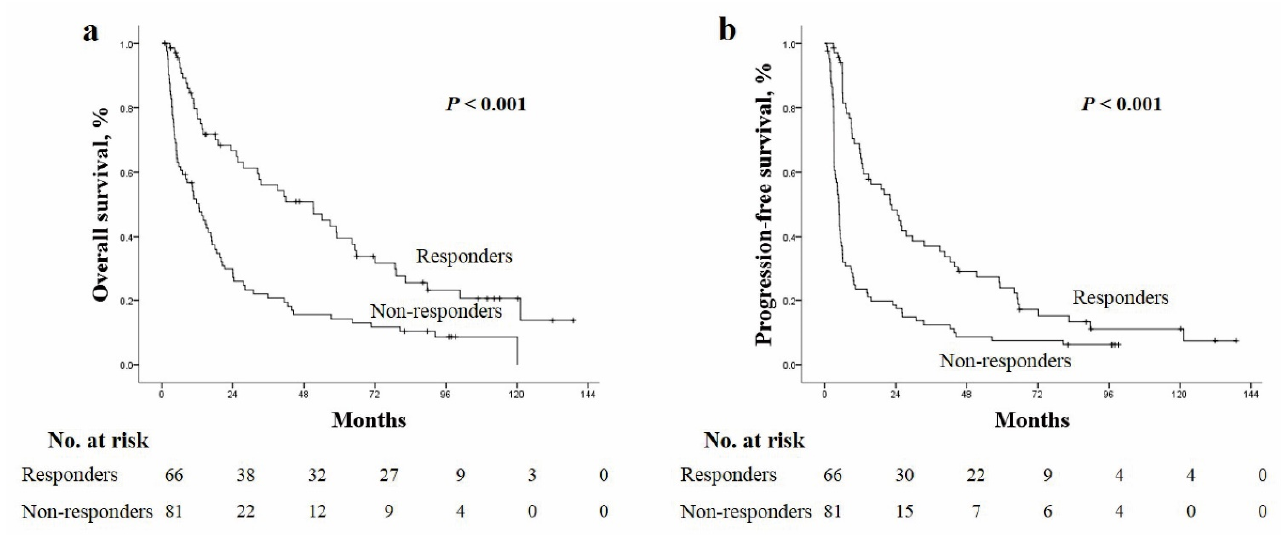
Figure 5. The Kaplan–Meier curves of ( a ) overall survival and ( b ) progression-free survival according to the presence of responders (complete and partial response).